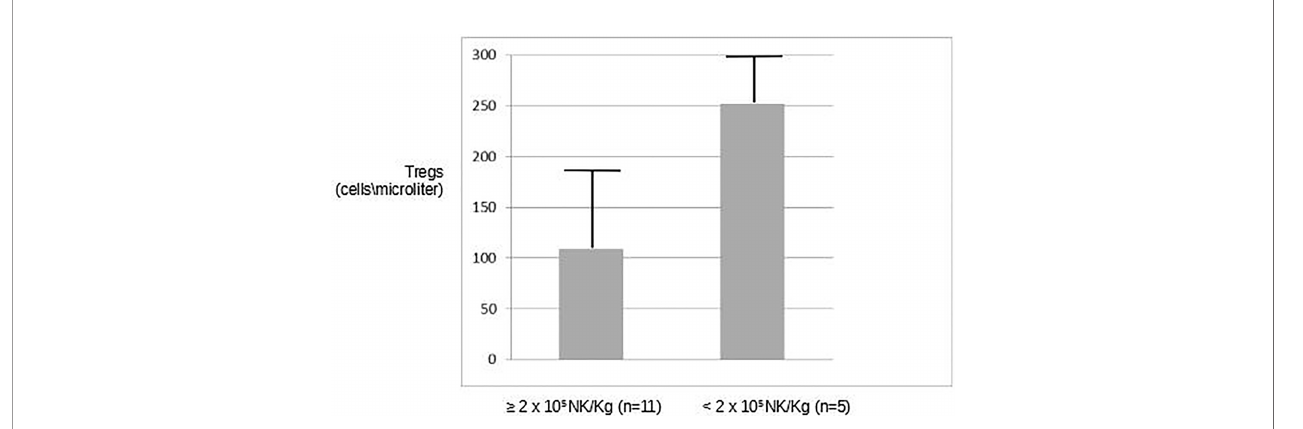
FIGURE 3 | Correlation between long-term clinical outcome and frequency of Tregs after infusion. A lower number of Tregs were observed in patients who had received more than 2 × 10 5 /kg alloreactive